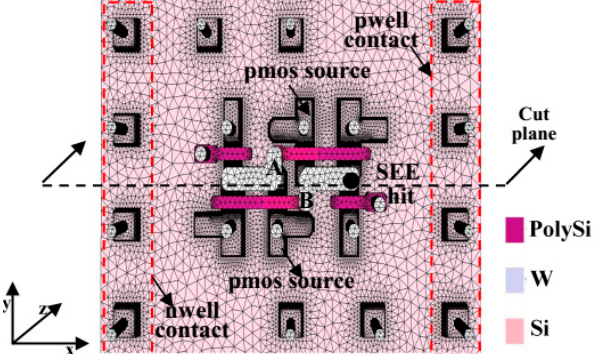
Figure 2. The top view of the simulated SRAM cell.